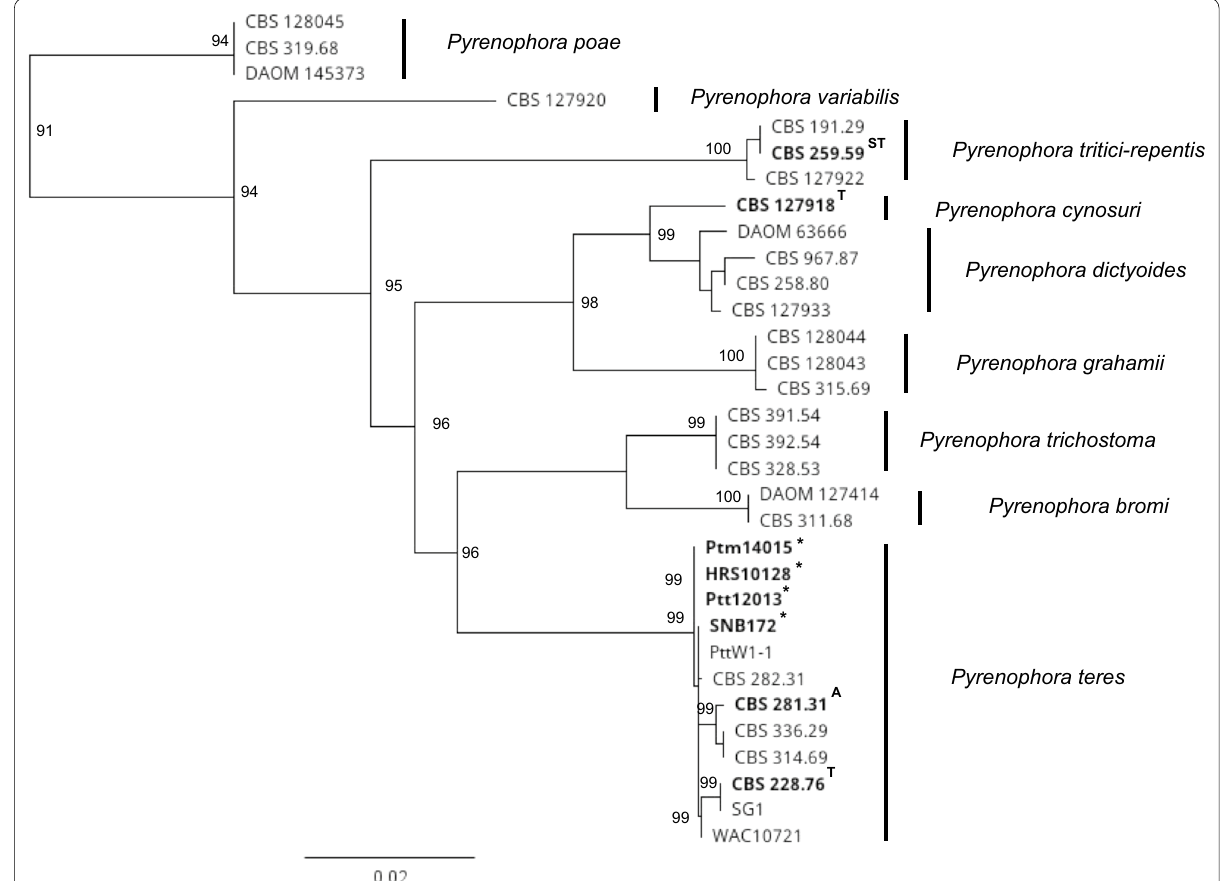
Fig. 6 Maximum likelihood phylogram of Pyrenophora species constructed using RAxML v.8 (Stamatakis 2014) from the concatenated alignment of internal transcribed spacers and intervening 5.8S nrDNA (ITS), partial large subunit of the nrDNA (LSU), partial glyceraldehyde‑3‑phosphate dehydrogenase gene ( gapdh ), and partial DNA‑directed RNA polymerase II second largest subunit gene ( rpb2 ). The tip labels in bold and A, ST and T represent authentic, ex‑syntype and ex‑type strains (Marin‑Felix et al. 2019), respectively, and asterisks denote isolates sequenced in the current study. Bootstrap support values > 90% are shown at nodes. The tree is rooted to P.